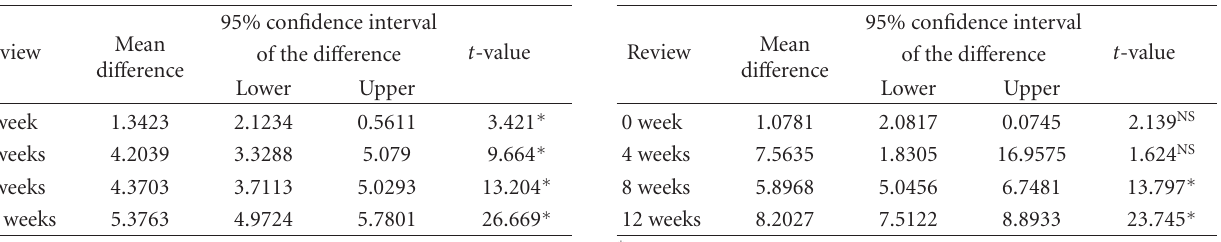
Table 1: Comparison of WOMAC pain mean score between group A and group B.